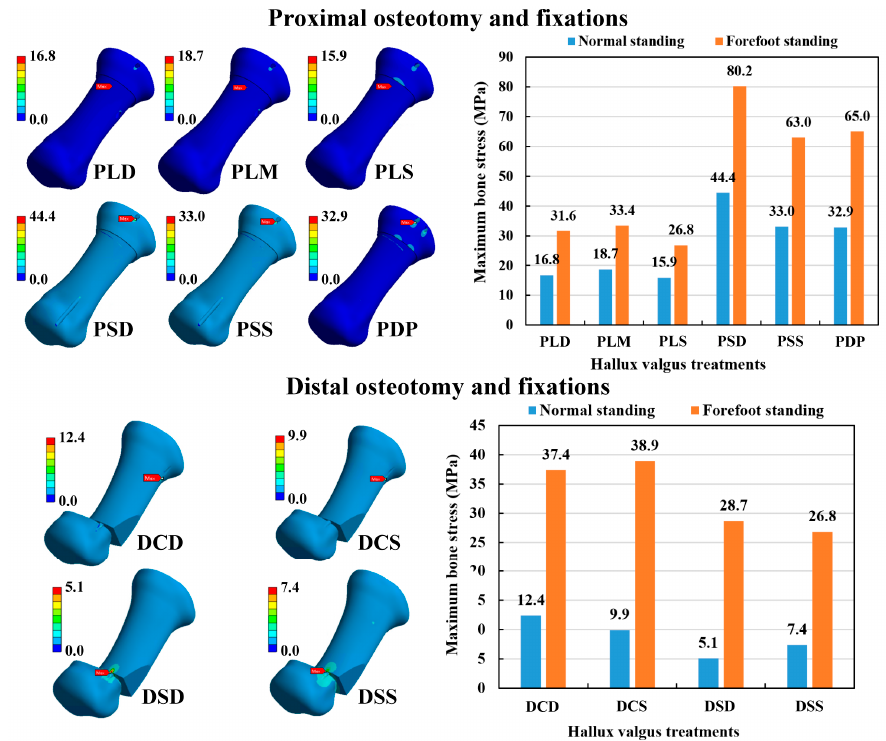
Figure 7. The bone stress distribution of the numerical models and the results of the maximum metatarsal bone stress.